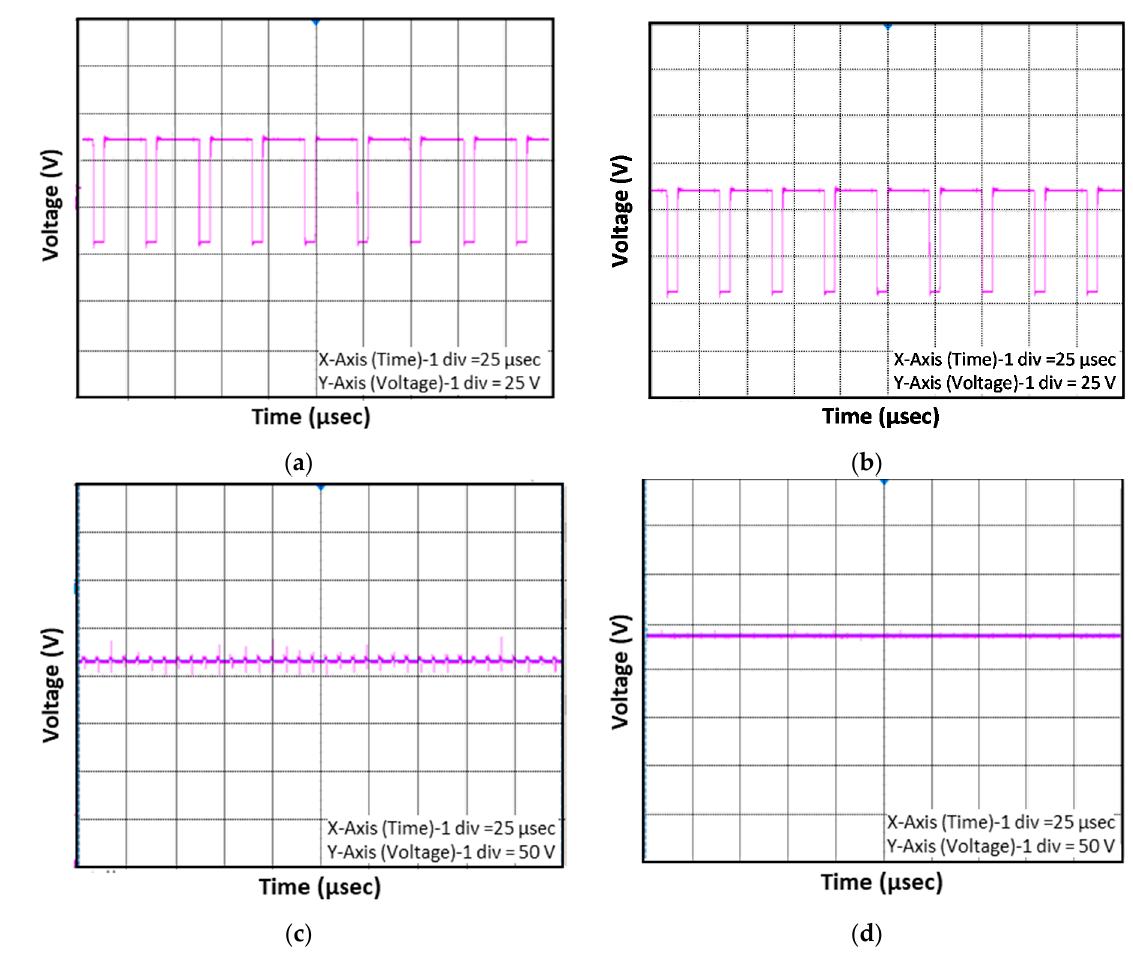
Figure 16. ( a ) Voltage across L 1 ; ( b ) voltage across L 2 ; ( c ) voltage across C 1 ; ( d ) voltage across C 2